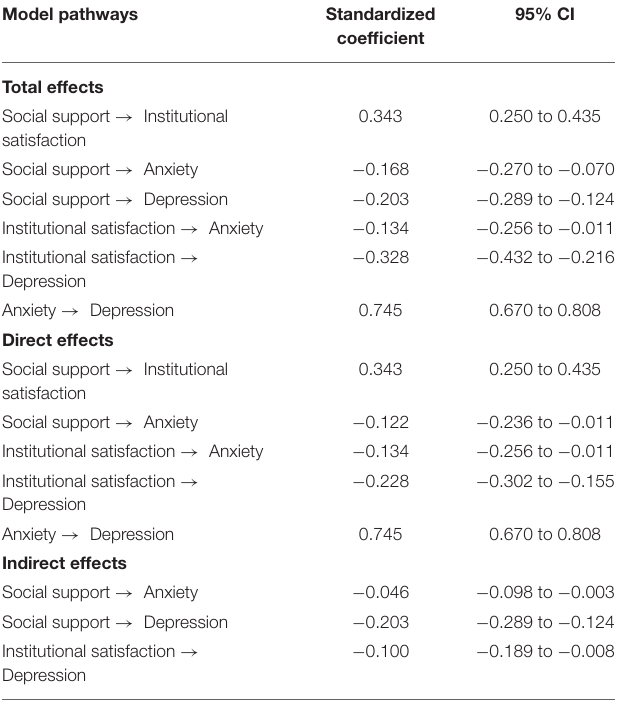
TABLE 5 | Direct, indirect, and total effects of key study variables.